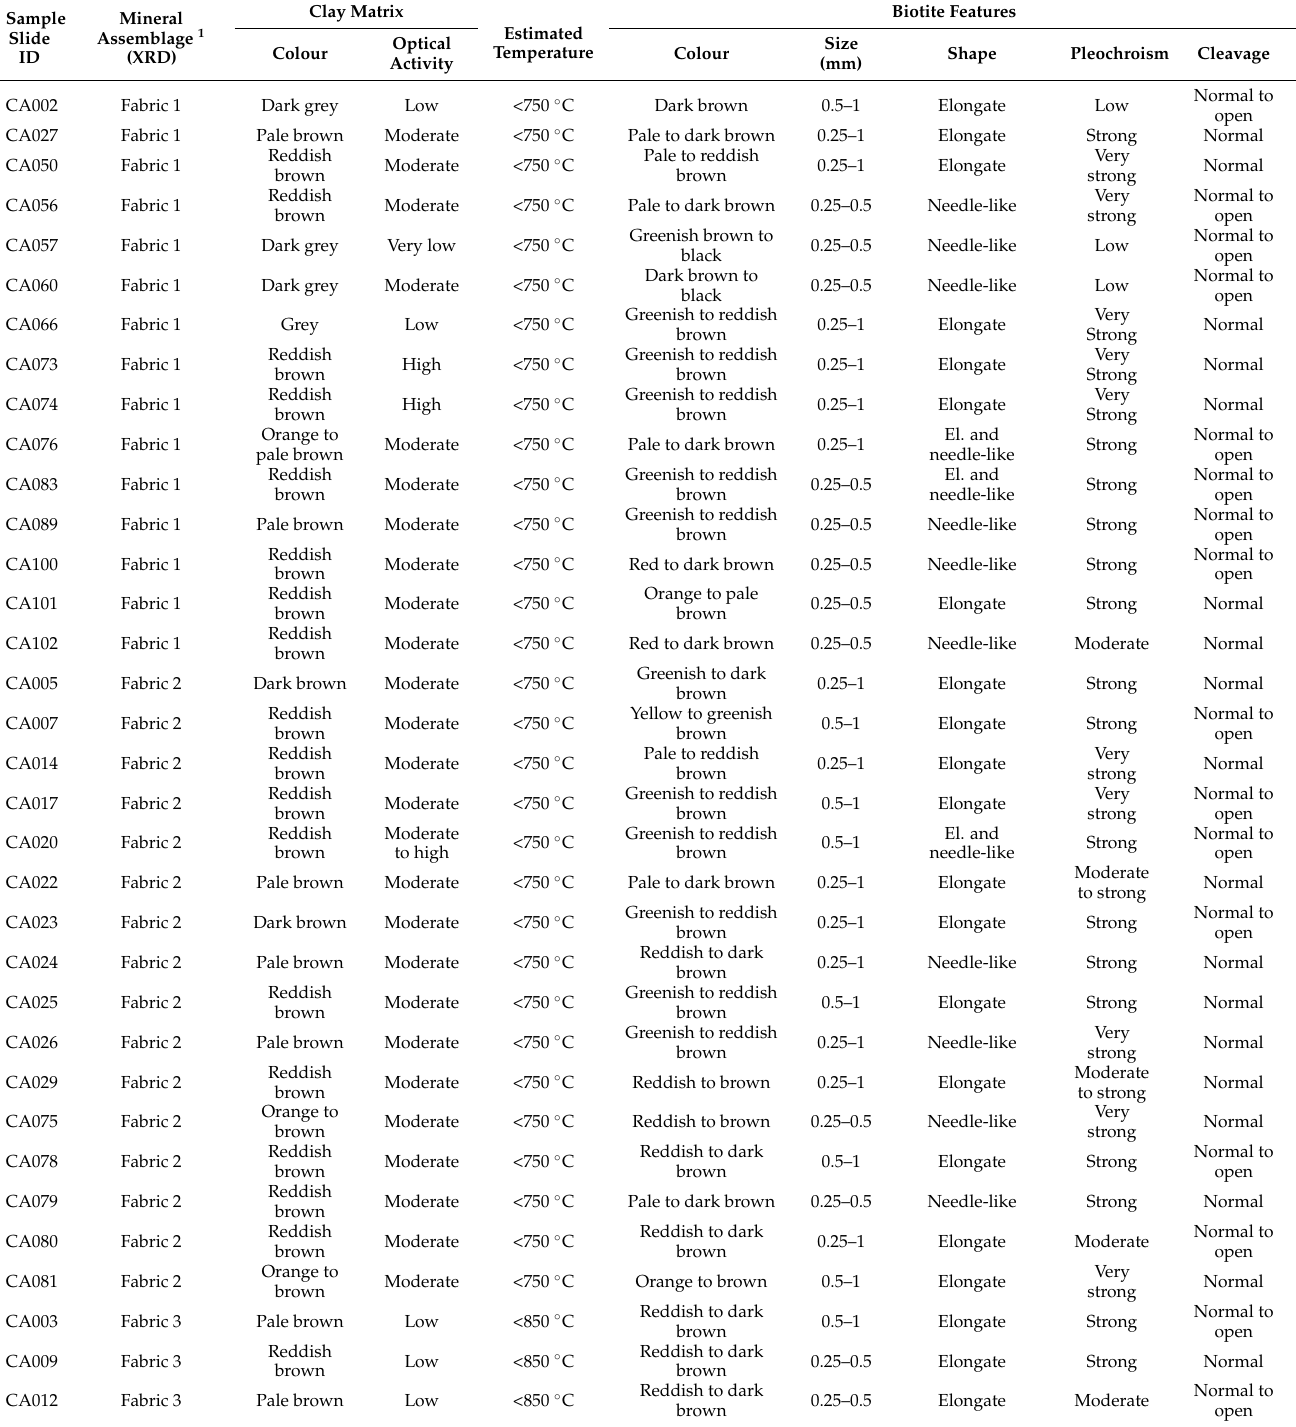
for 100 samples from Cabrera d’Anoia. Samples are classified according to 12 fabrics with specific mineral assemblages that allow us to estimate their firing temperature range. Table A2. Details of 100 medieval greyware pottery wasters analysed from Cabrera d’Anoia in previous research [3], including their mineralogical assemblages as determined by XRD, the colour and optical activity in thin-sections under crossed polars, their estimated firing temperature and the optical properties of the biotite inclusions contained within. Please see [56] (pp. 402–403) for petrographic fabric and geochemical group ascription and [3,56] for further